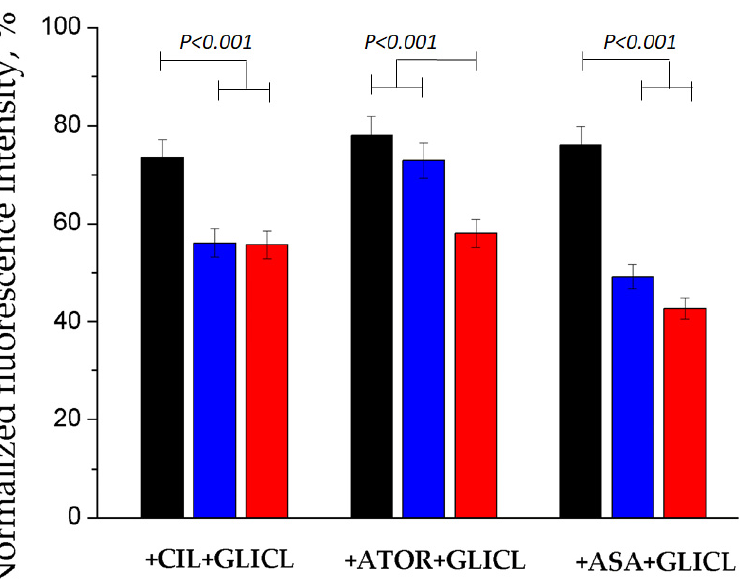
Figure 4. Changes in fluorescence intensity of BSA solutions (nonglycated and glycated at different degrees) after the addition of 14 µ M gliclazide (molar ratio 1:7) in the presence of another drug observed at 295 nm excitation wavelength. Fluorescence is normalized to the value observed for the BSA-DRUG (cilazapril, atorvastatin or acetylsalicylic acid) complex and expressed as percentage. The colors of the bars refer to the following: native BSA—black, g10_BSA—blue, g30_BSA—red. Statistical significance was calculated using ANOVA, and P < 0.05 was considered